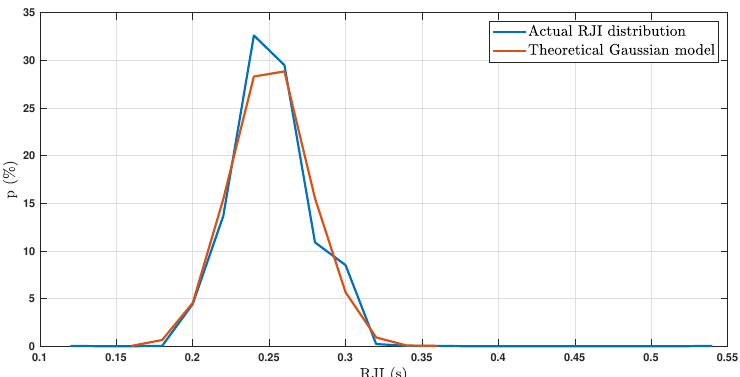
Figure 3. RJI data and a theoretical Gaussian fit based on mean and standard deviation of the RJI data.